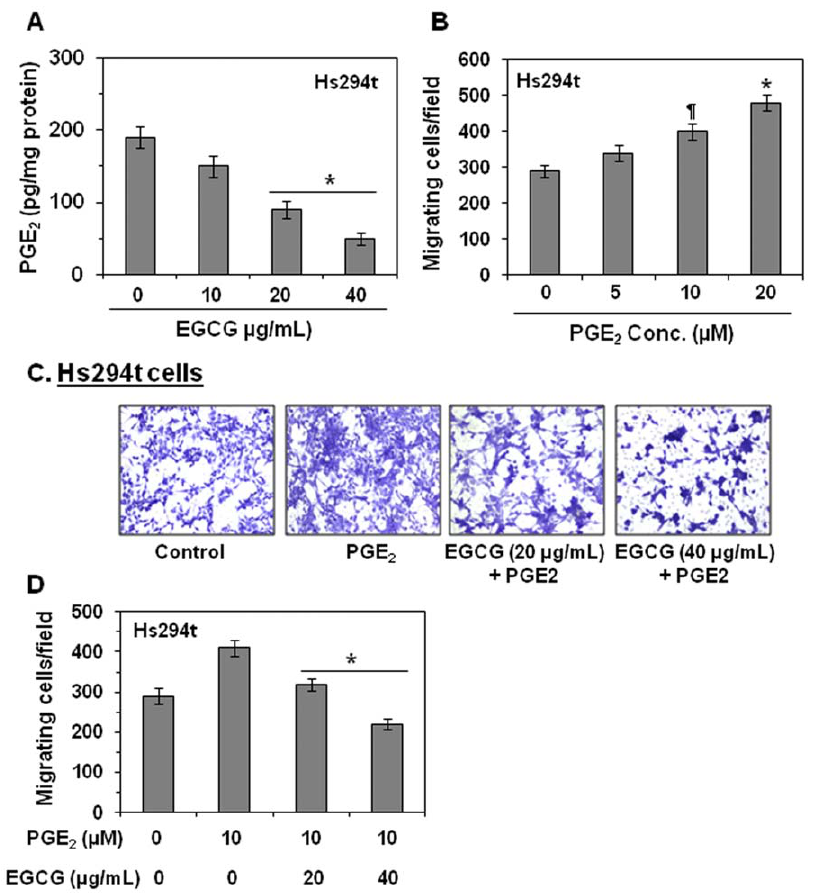
Figure 4. EGCG inhibits PGE 2 -induced melanoma cell migration. ( A ) Dose-dependent effect of EGCG on the levels of PGE 2 in melanoma Hs294t cells. The levels of PGE 2 are expressed in terms of pg/mg protein 6 SD, n=3 independent experiments. Significant inhibition by EGCG versus non-EGCG-treated controls, * P , 0.001. ( B ) Treatment of Hs294t cells with PGE 2 enhances cell migration in a concentration-dependent manner. Significant difference versus control, " P , 0.05, * P , 0.001. ( C ) Treatment of cells with EGCG (20 and 40 m g/mL) inhibits PGE 2 -enhanced cell migration capacity of Hs294t cells. Representative photomicrographs of cell migration were presented from three independent experiments. ( D ) The data on cell migration are summarized as a mean number of migratory cells 6 SD/microscopic field. Significant inhibition versus PGE 2 alone: * P , 0.001. Cell invasion assays under each experiment were repeated three times and in each case the migrating cells were counted and the results are expressed as a mean number of migratory cells 6 SD/microscopic field. determined on the migration of A375 melanoma cells. As shown in 10, 20 and 40 m g/mL) for 24 h resulted in a dose-dependent Figure 5D, EP4 agonist treatment of A375 cells for 24 h reduction in the levels of EP2 and EP4 (Figure 5A). The inhibitory significantly enhanced ( P , 0.001) the cell migration in a dose- effect of EGCG was also observed on EP1 and EP3 but was less dependent manner. Treatment of cells with EGCG (20 and prominent than the effect on EP2 and EP4 (data not shown). 40 m g/mL) significantly inhibited (41–66%, P , 0.01 and P , 0.001) EP4 agonist-induced cell migration (Figure 5E, left and right panels). These data suggest that the expressions of PGE 2 receptors in melanoma cells have roles in cell migration, and that EGCG inhibits the migration of melanoma cells, at least in part, by decreasing the levels of PGE 2 receptors.